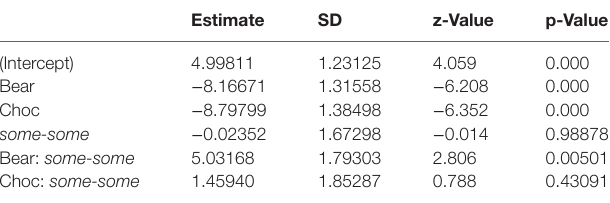
TaBle a1 | Summary of logit mixed effects model for Experiment 1 (n = 456, log-likelihood = −